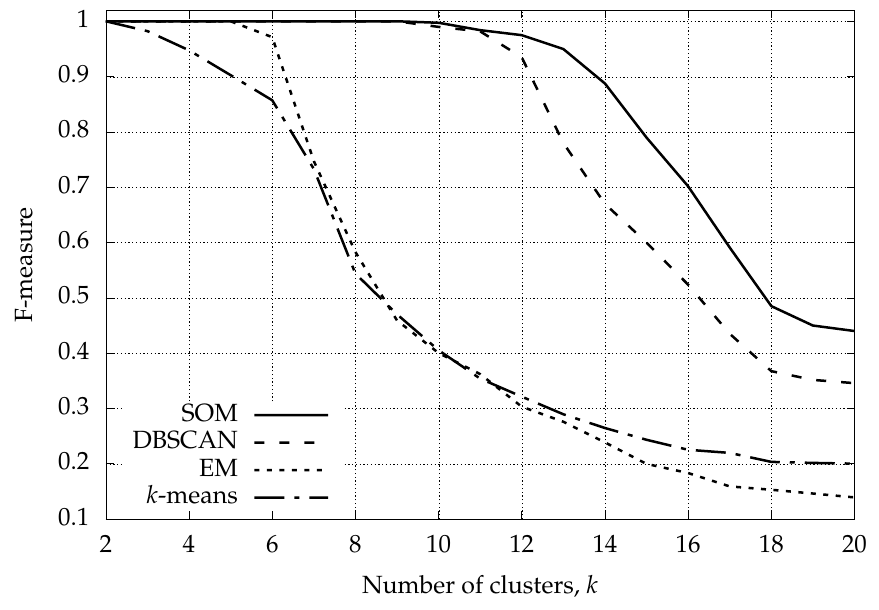
Figure 7. Weighted F-measure for the four selected clustering techniques vs. the number of clusters k . Table 2. Average Weibull parameters for the 5 synthetic